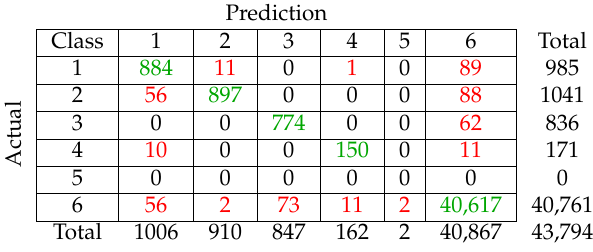
Table 6. Confusion matrix displaying results from the decision tree classifier. The green highlighted numbers are true positives, and the red highlighted numbers are false positives.